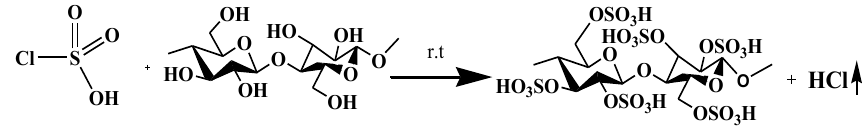
Figure 3. The reaction of chlorosulfonic acid and silica gel in presence of inert